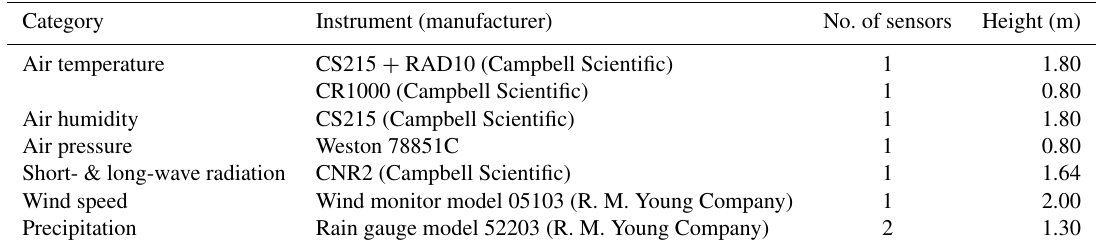
Table 3. Meteorological instrumentation with approximate height above